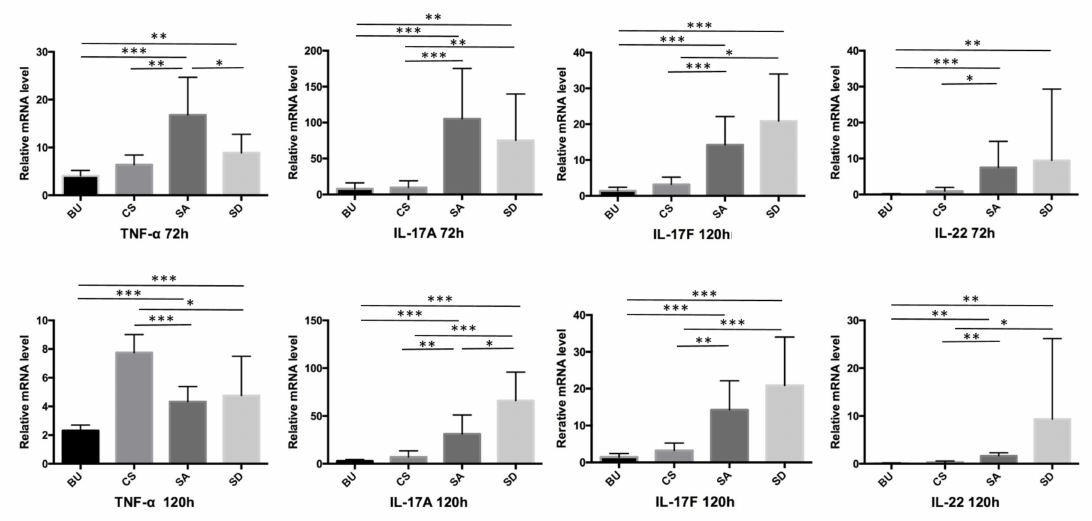
Figure 4. The expression of TNF- α , IL-17A, IL-17F, and IL-22 genes is elevated in SA- and SD-fed mice compared with controls. * p < 0.05, ** p < 0.01, *** p <